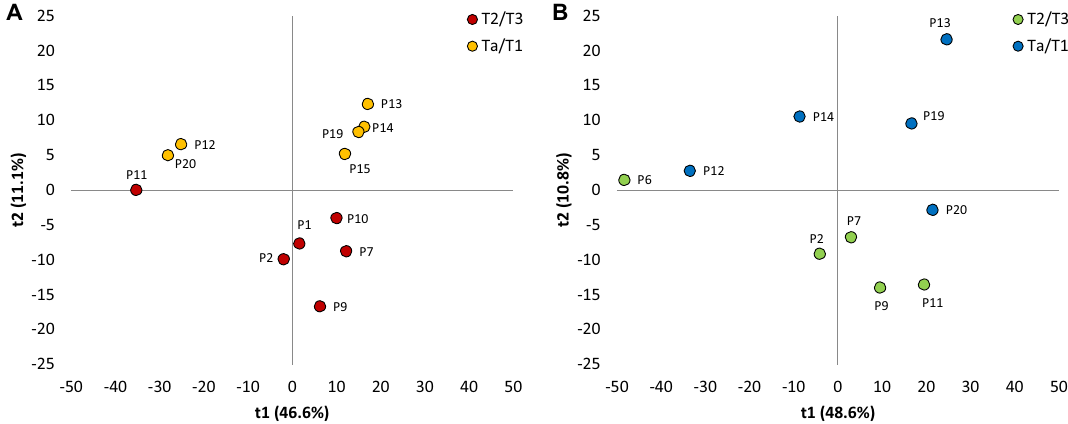
Figure 3. PCA score plots (t2 vs t1) of data from proteins commonly found among samples according to their tumour stages samples preserved by FFPE ( A ) and OCT ( B ). For FFPE: Patients 1, 7, 9, 10 and 11 were diagnosed with stage T2/T3, and patients 12, 13, 14, 15, 19 and 20 were diagnosed with stage Ta/T1. For OCT: Patients 2, 6, 7, 9 and 11 were diagnosed with stage T2/T3, and patients 12, 13, 14, 19 and 20 were diagnosed with stage Ta/T1. Created using Microsoft Office Professional Plus 2016.